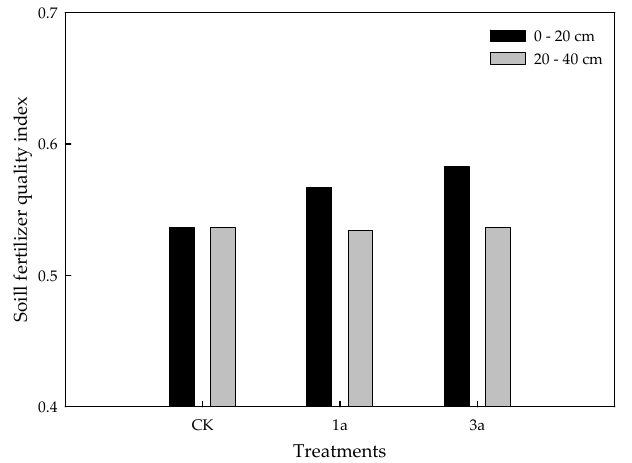
Figure 4. Soil quality comprehensive index after returning shoots for different times. CK: control; 1a: shoots returned for 1 year; 3a: shoots returned for 3 years.